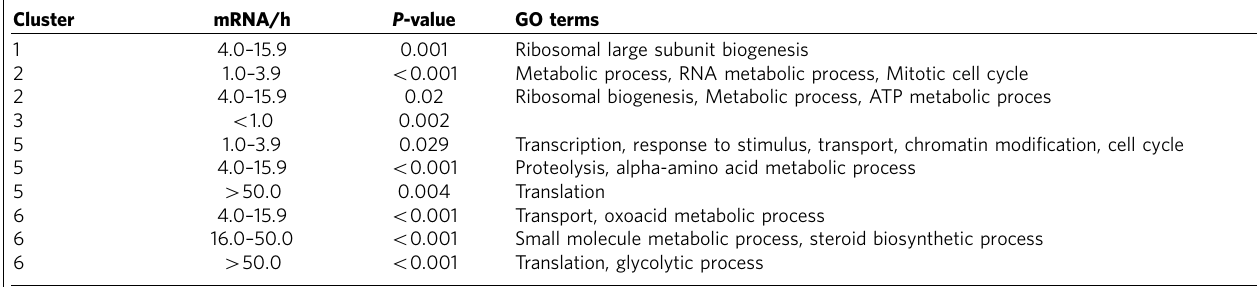
Table 3 | Chart shows transcription rates for genes within the six k -means clusters.